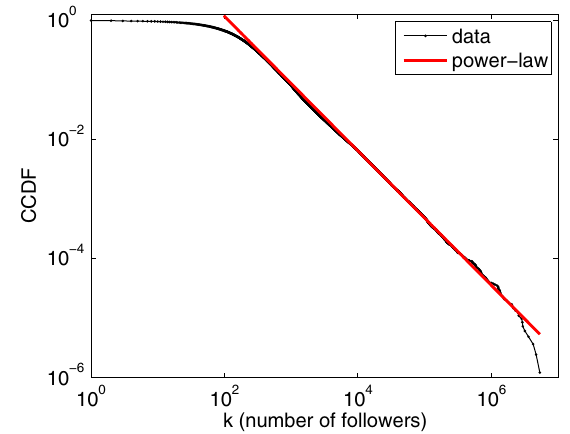
FIG. 5. CCDF for the number of followers k of a random sample of 8 . 2 × 10 5 Twitter users. The straight line corresponds to an out-degree distribution with tail scaling as p k → ∞ , with D ¼ 240 and γ ¼ 2 . 13 ( x described in Ref. [66]).